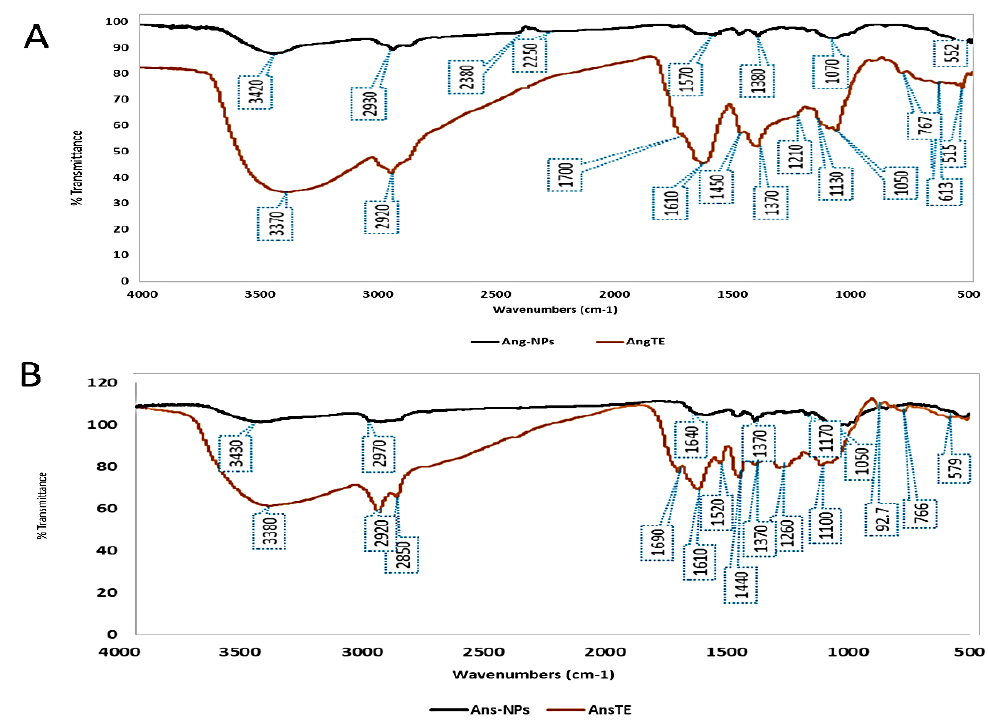
Figure 2. FTIR spectrum of the biosynthesized silver nanoparticles, ( A ): Ang-AgNPs and ( B ): Ans- AgNPs compared to their respective extracts, AngTE and AnsTE.